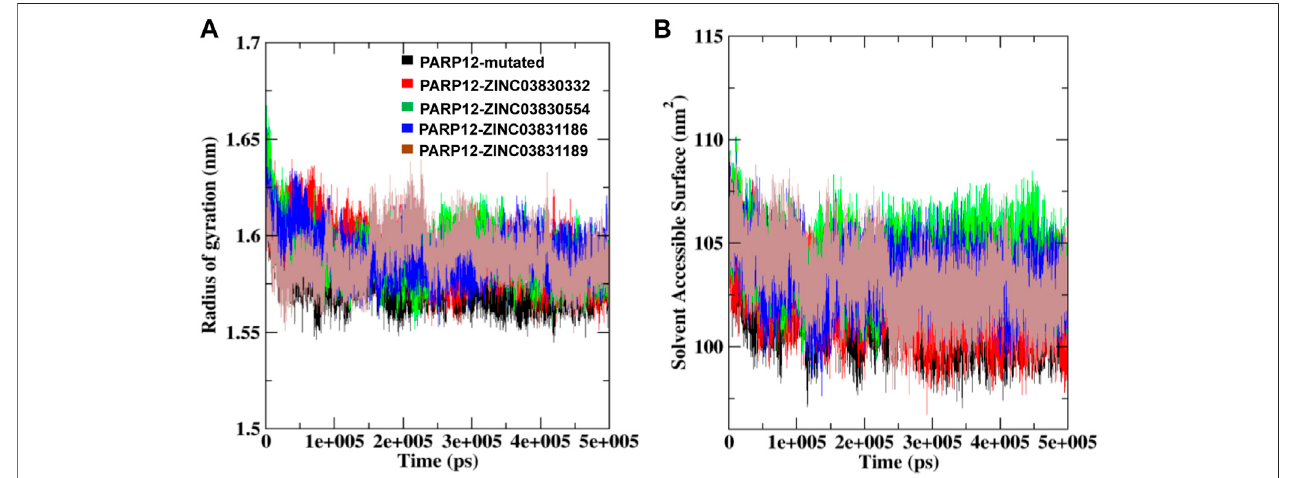
FIGURE 5 | (A) Rg and (B) SASA fl uctuations per residue variation plot analysis of the mutant system and in the presence of compounds with PARP12 at total simulation